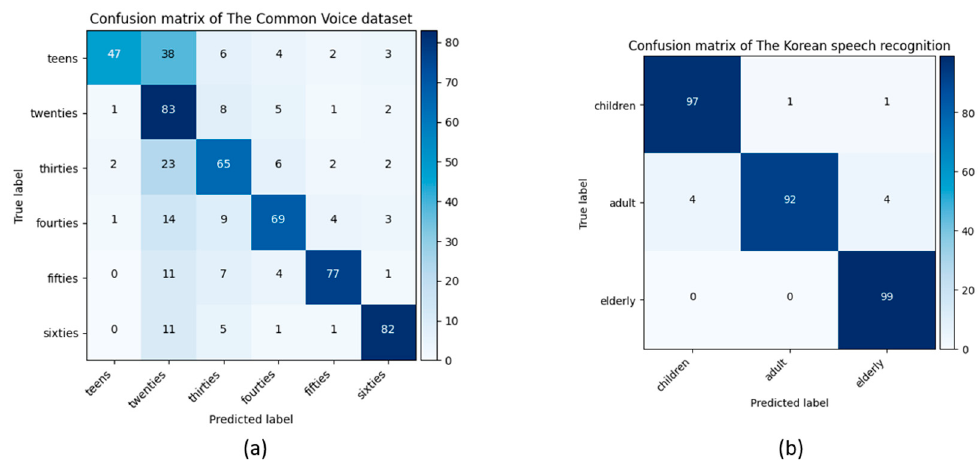
Figure 5. Obtained confusion matrices of the proposed model for the Common Voice ( a ) and Korean speech recognition ( b ) datasets for age classification with 72% and 96% average recognition rates.